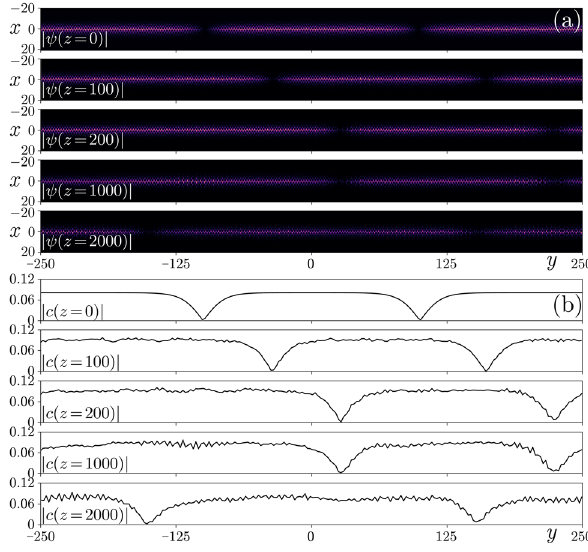
Figure 4: Profiles (a) and projections (b) of the dark valley Hall edge soliton at selective distances in the lattice with weak random